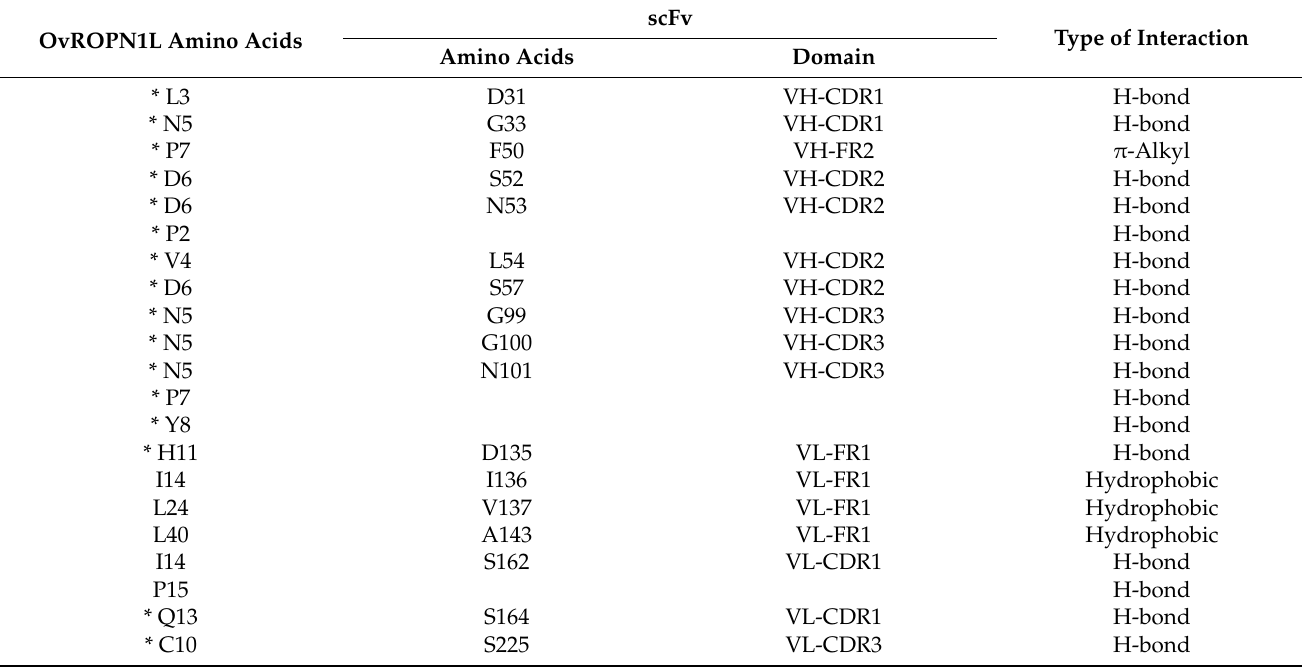
Table 1. Amino acid interactions between the OvROPN1L peptide and scFv anti-OvROPN1L-CL19.